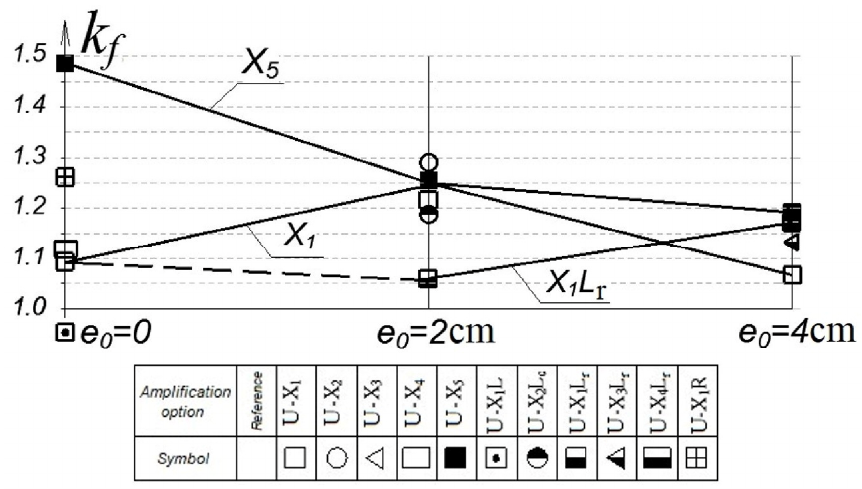
k . f e = 0. At an eccen- 0